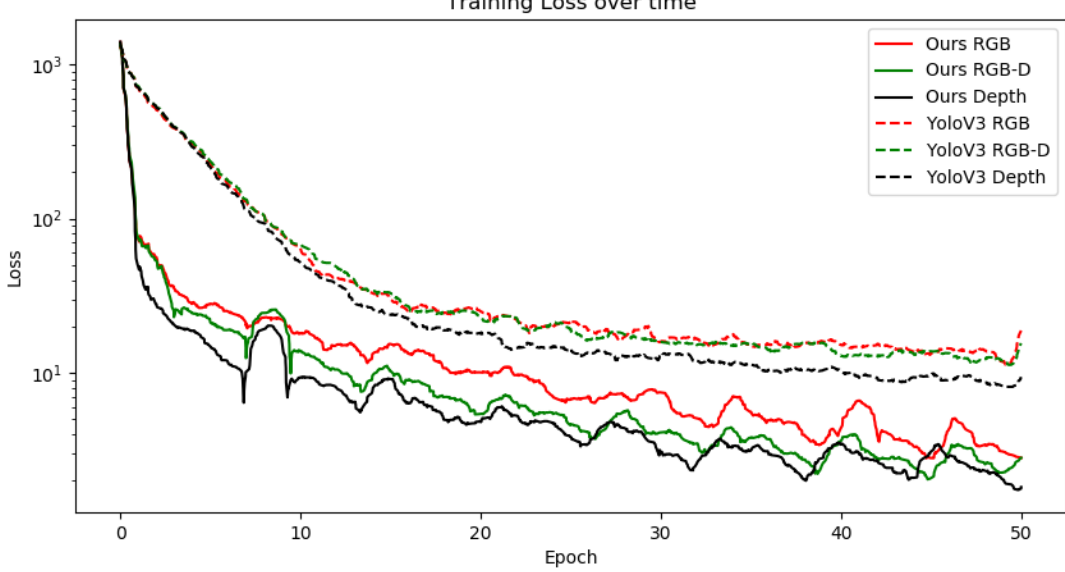
Figure 3. Training loss comparison between baseline YOLOv3 and our modified version when using RGB, RGB-D and depth data as training. Due to the loss function being inherently noisy for each of the mini-batches, we have used Savitzky-Golay [52] digital filter to perform the smoothing of the overall